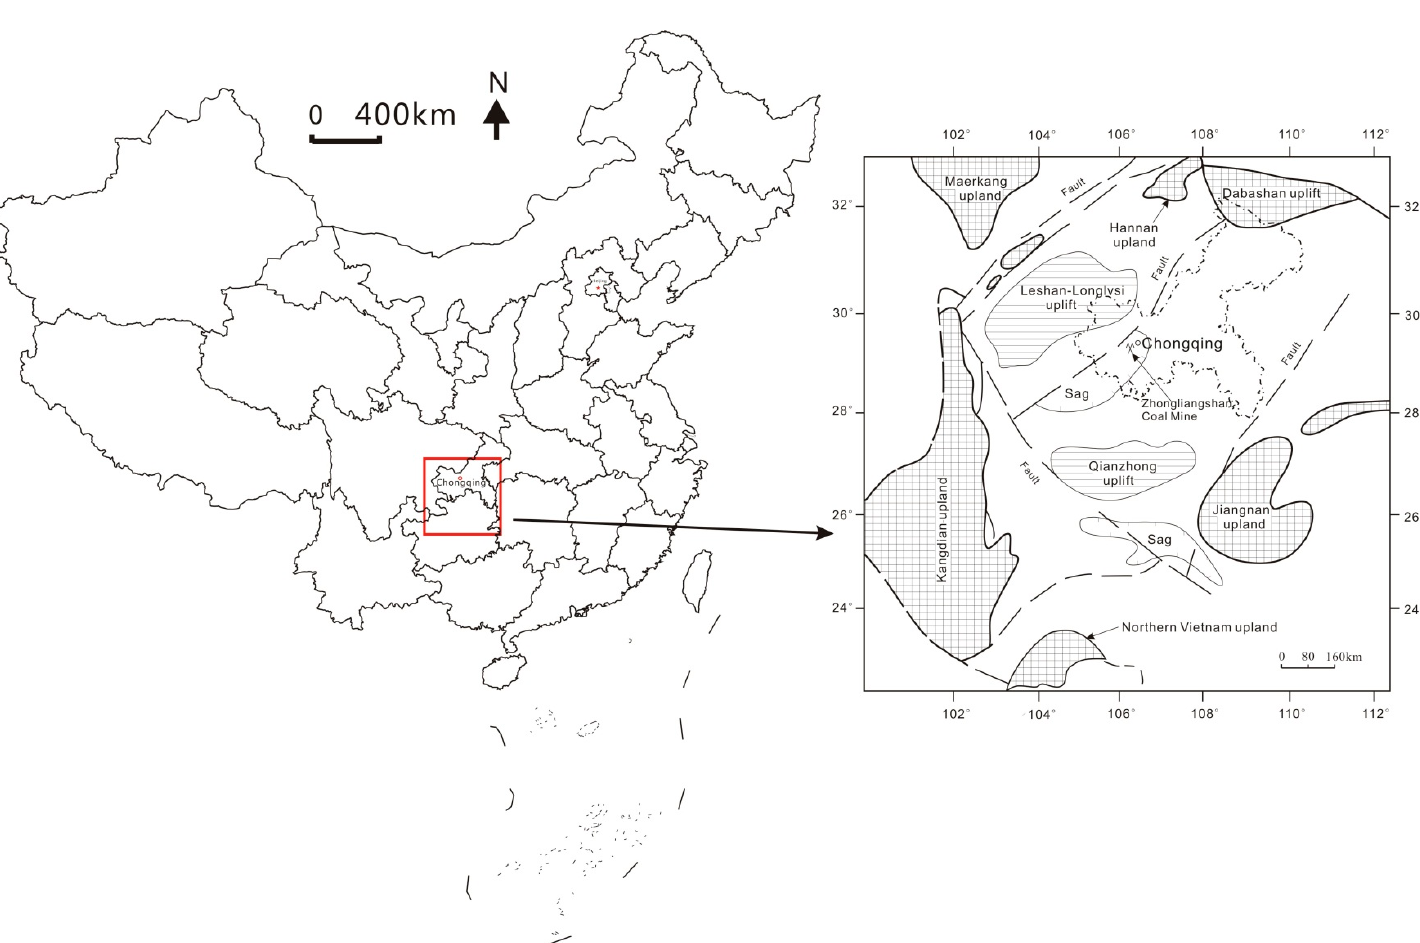
Figure 1. Location of the Zhongliangshan Mine, Chongqing, southwestern China.